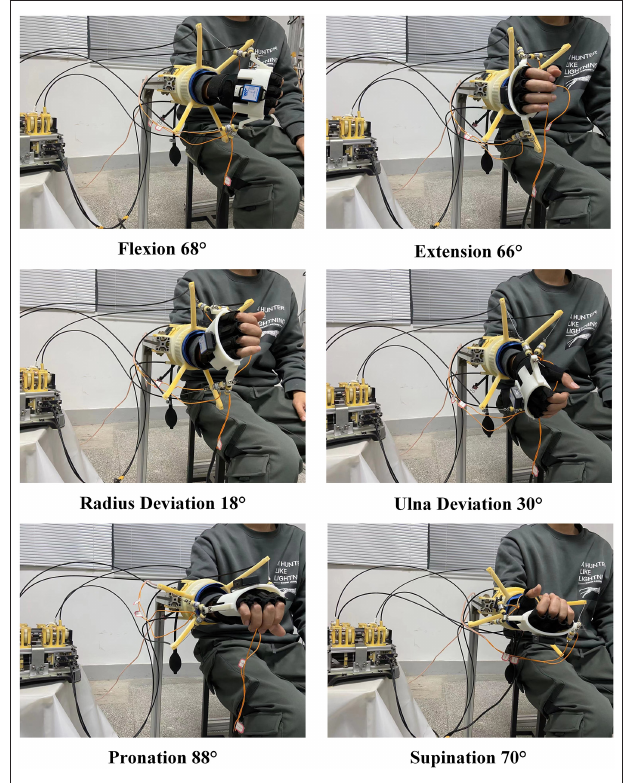
FIGURE 10 | The actual workspace in